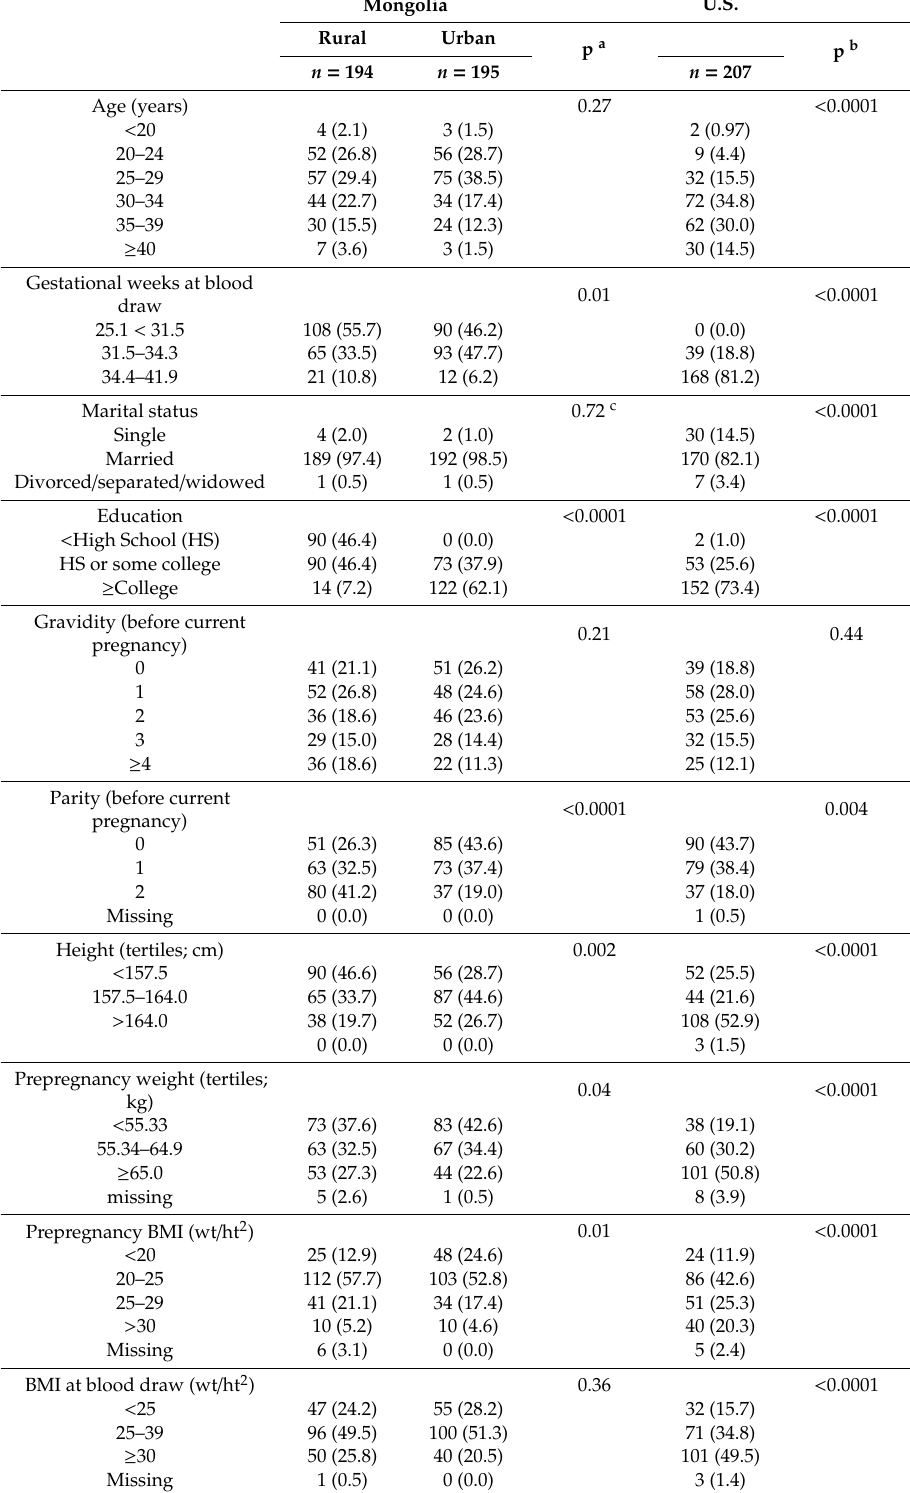
Table 1. Number (%) of Rural and Urban Mongolian and U.S. Women by Demographic, Anthropometric and Pregnancy